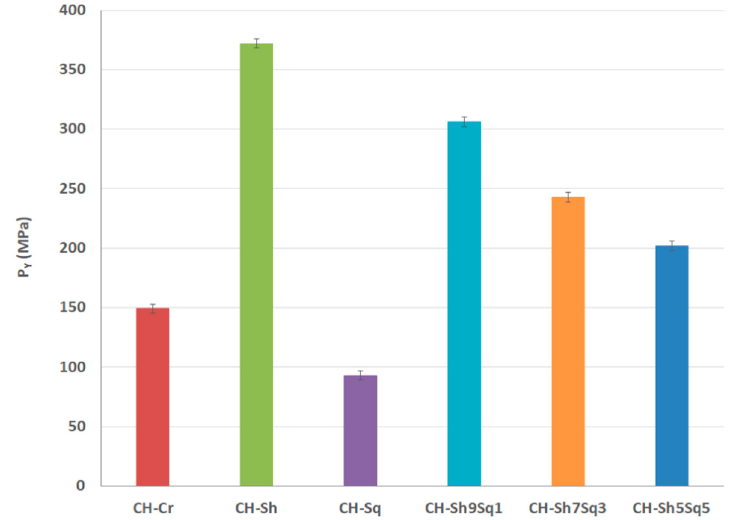
Figure 9. Heckel parameter ( P Y ) for CH-Cr, CH-Sh, and CH-Sq and their mixtures.